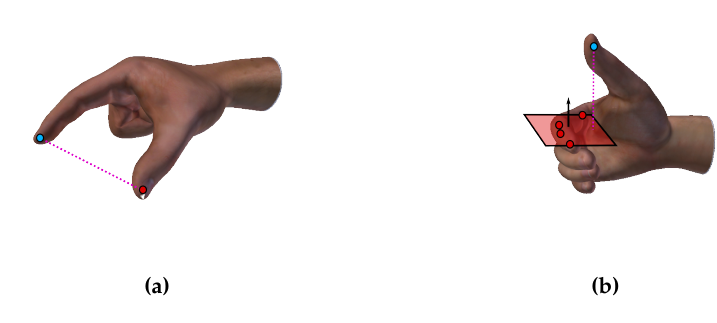
Figure 4. Graphical illustration of the distances computed to evaluate the percentage of completeness for the rehabilitative exercises: ( a ) pinch grasp; ( b ) lateral grasp. We used the 3D hand model from the libhand library [35] for illustration purpose.